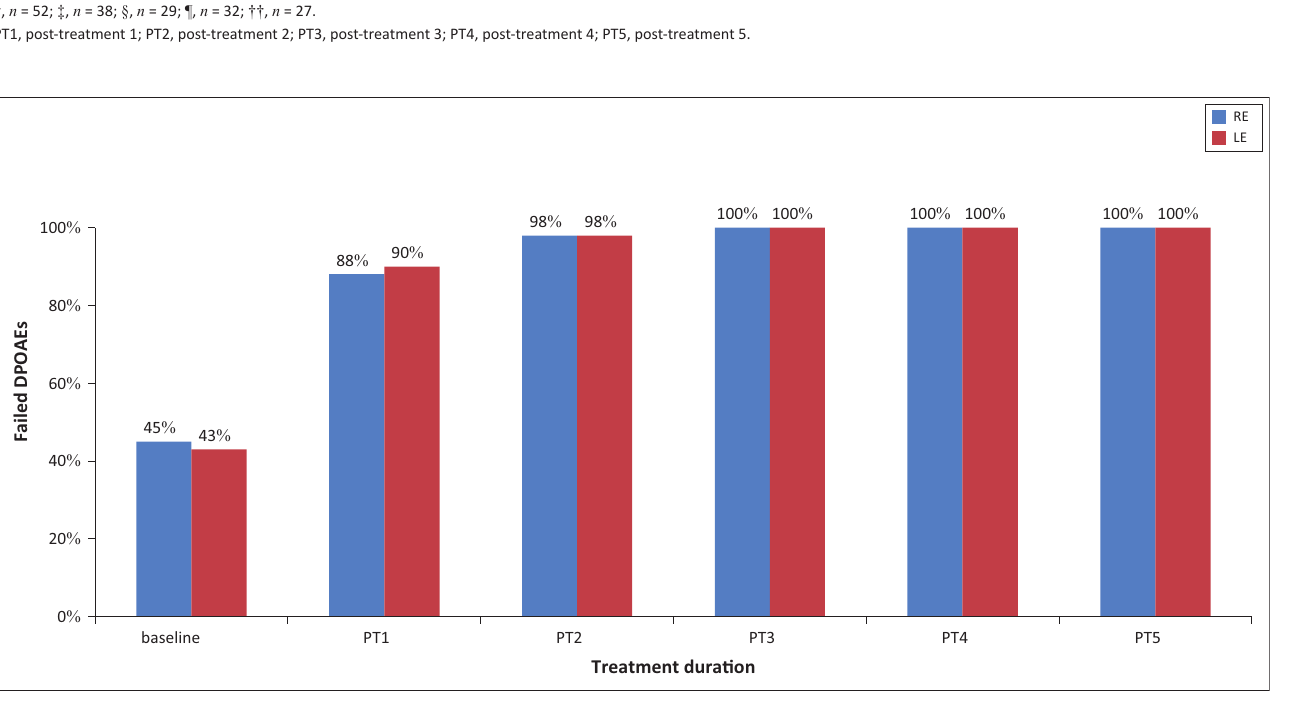
FIGURE 10: Distortion product otoacoustic emissions over treatment